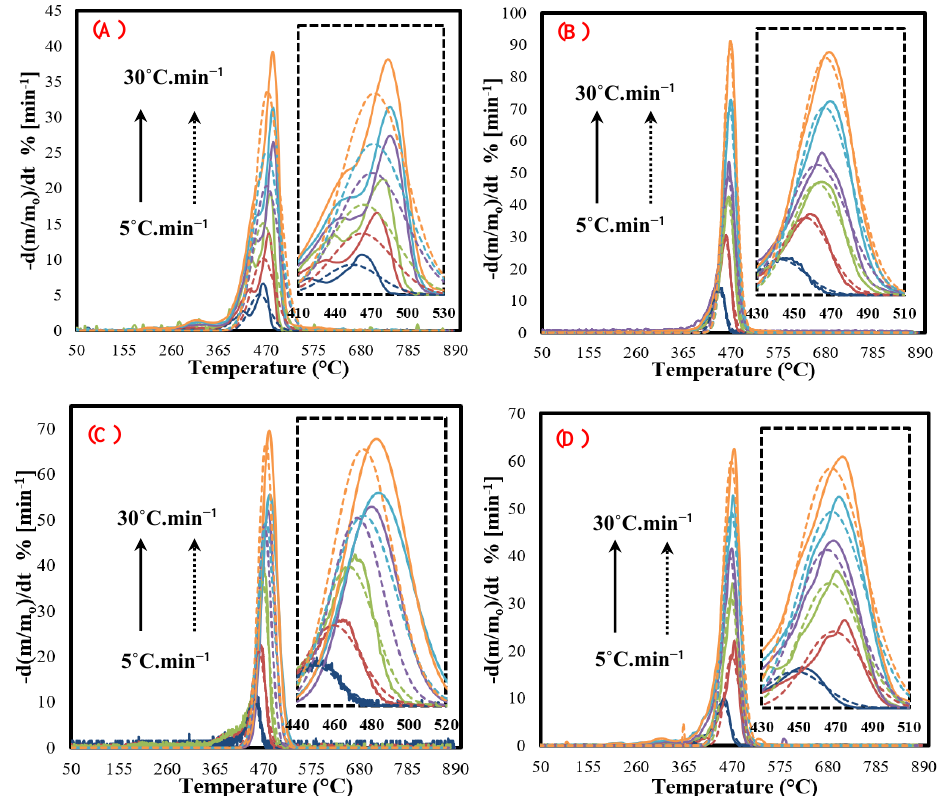
Figure 3. Experimental (solid lines) and calculated results (dotted lines) of the IPR model at heating rates 5–30 °C min −1 for ( A ) coffee, ( B ) chips, ( C ) chocolate, and ( D ) and mixed sample.